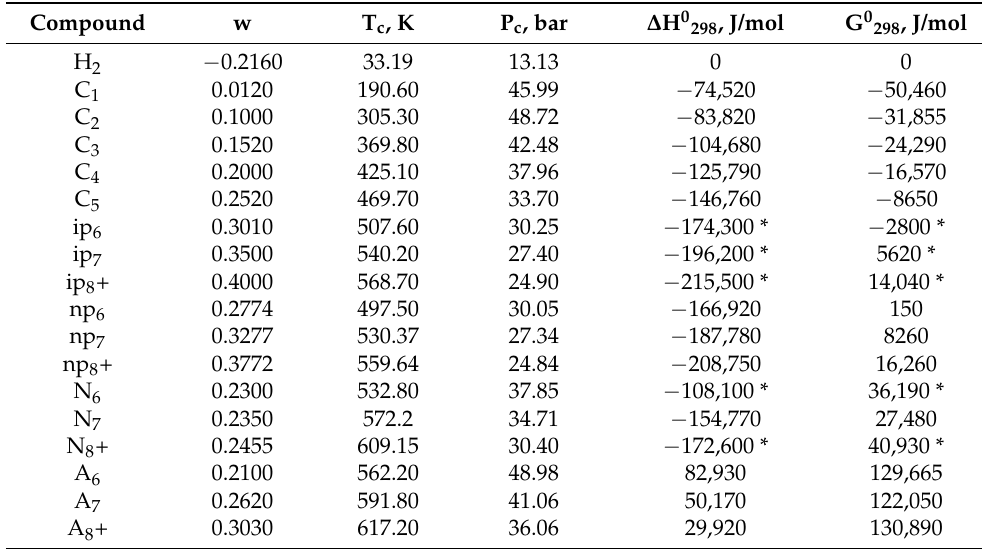
Table 2. Critical properties and ideal gas standard Gibbs free energy [21].